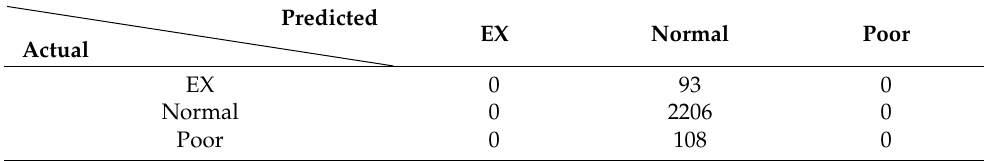
Table 4. Confusion matrix of C5.0 in Case 2 (fold